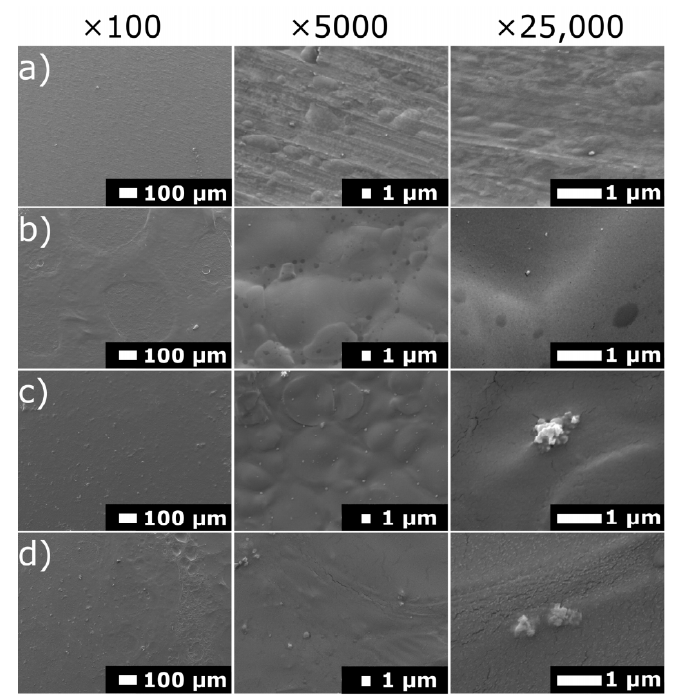
Figure 9. SEM images of the surface of the: ( a ) bare titanium substrate, ( b ) chit/EE100, ( c ) A1, and ( d ) B1 coatings after electrochemical tests; at different magnifications, × 100 (on the left), × 5000 (in the middle), and × 25,000 (on the